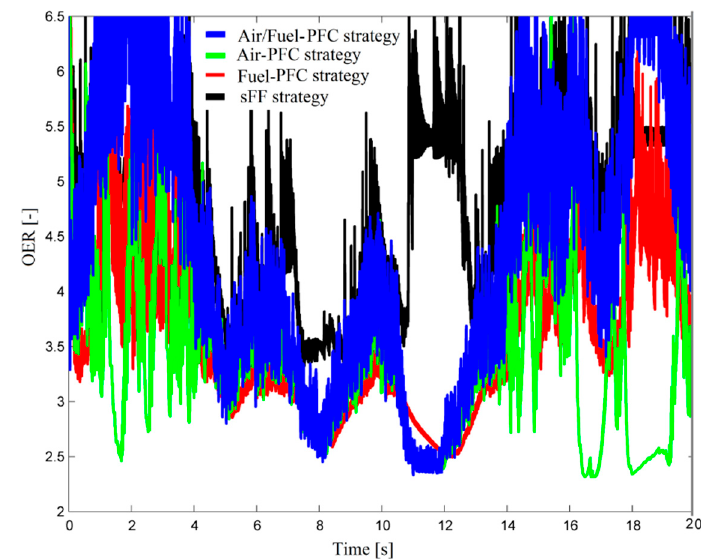
Figure 15. Oxygen excess ratio.